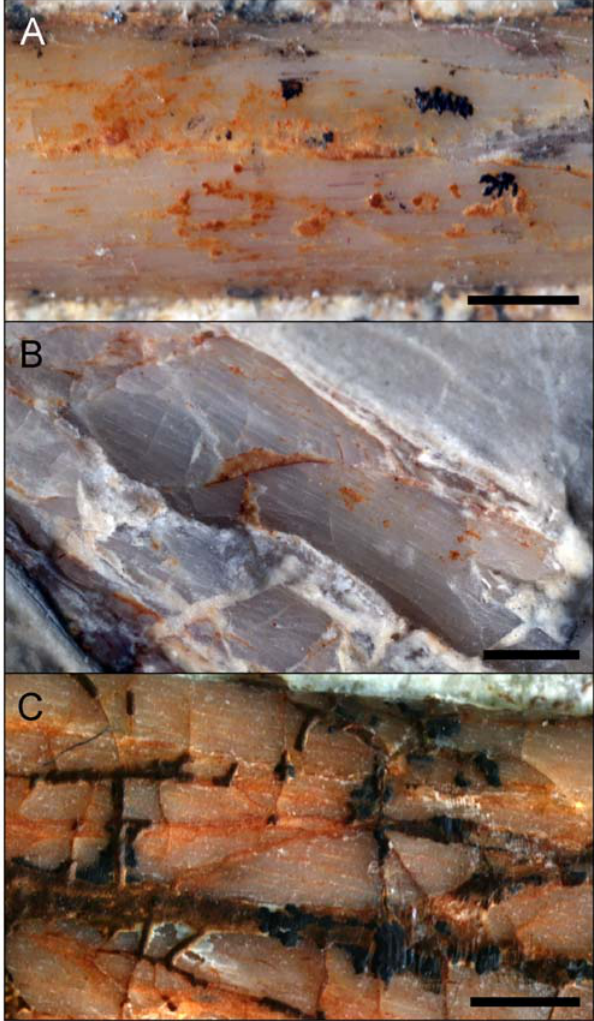
Figure 3. Fibrous surface texture and longitudinal vascular canals visible within the cortices of Archaeopteryx long bones. (A) Tibial diaphysis from the smallest known Archaeopteryx , the Eichsta¨t specimen (JM 2257) showing sparse longitudinal vascularization in the form of parallel striae. Comparable immature texture and patterning is found in the major long bones throughout the Archaeopteryx growth series. For example, it is seen in the tibiae of the moderately larger Munich specimen (BSPG 1999 I 50) shown in (B), and in the largest known individual (The Solnhofen specimen, BMMS 500) shown in (C). Scale bars =1.5